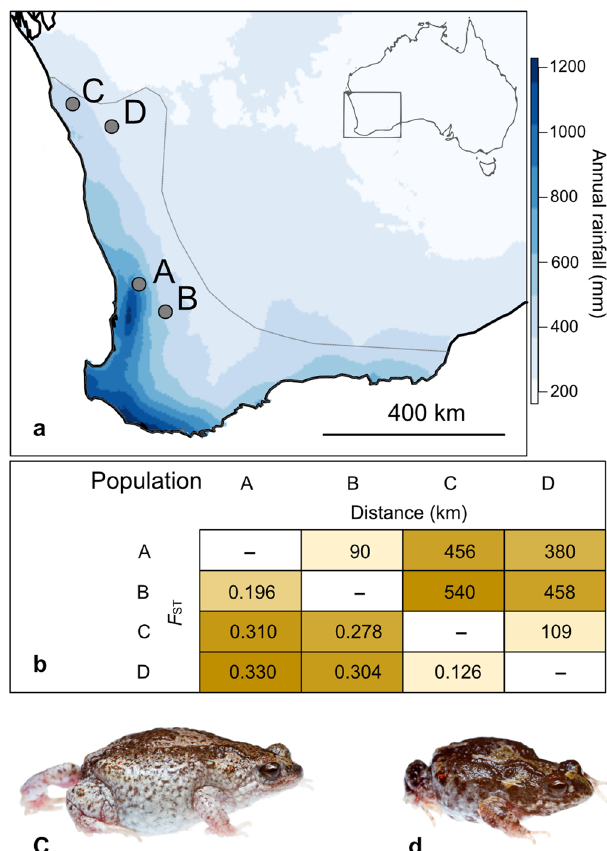
Fig. 1 Details of four breeding populations in southwestern Australia from which adult P. guentheri were collected. a The species ’ distribution (grey line; based on occurrence records from the Atlas of Living Australia) spans a ~300 – 1250 mm annual rainfall gradient, and both adults and terrestrial embryonic stages show clinal variation in desiccation tolerance, with range edge populations being more resistant to dry conditions than populations at the core of the species range 37 . b Matrix of pairwise geographic and genetic distances between populations, where genetic distances ( F ST ) were calculated in an earlier study 39 using 12,787 selectively neutral SNP loci. c a gravid female (collected from all sites except D). d an adult male (collected from all